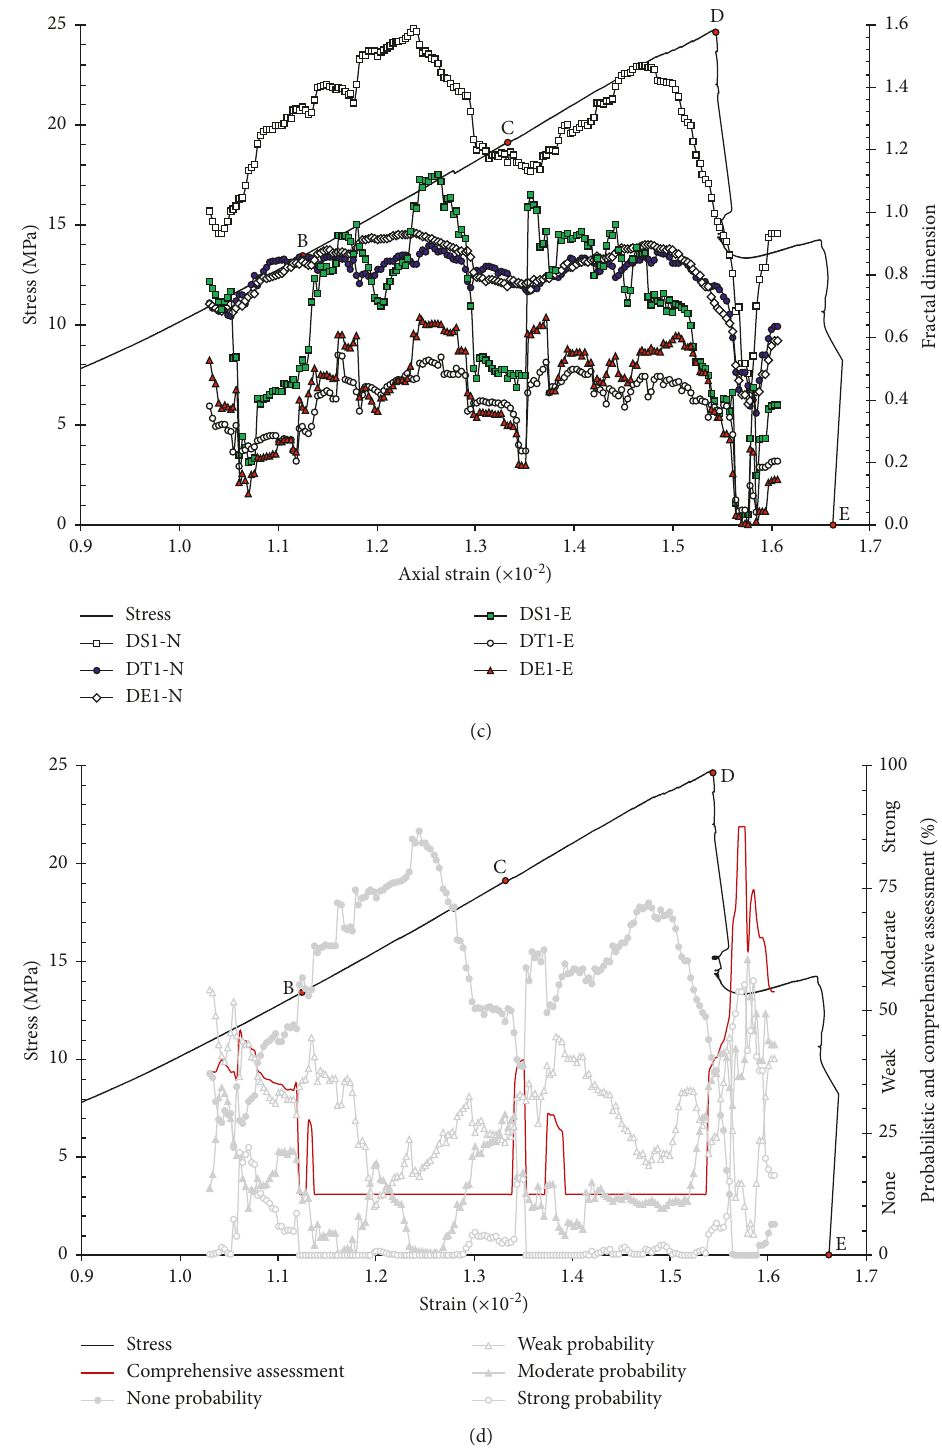
Figure 3: Evolution of AE performance, the associated fractal dimensions, and the probabilistic and comprehensive assessment along with the stress-strain curve when a coal sample is being loaded to failure. (a) AE performances along with stress-strain curve. (b) Fractal capacity dimension indices ( D S 0 , D T 0 , and D E 0 ) in qualitative trend analysis. (c) Additional six fractal information dimension indices. (d) Probabilistic and comprehensive